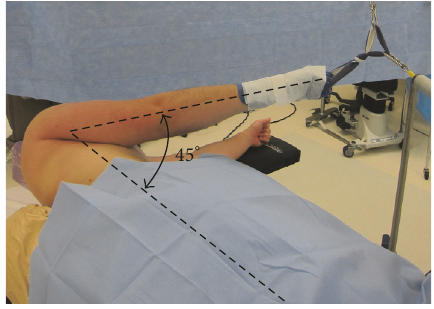
Figure 3: Recreation demonstrating 45 ∘ of flexion and 0 ∘ of